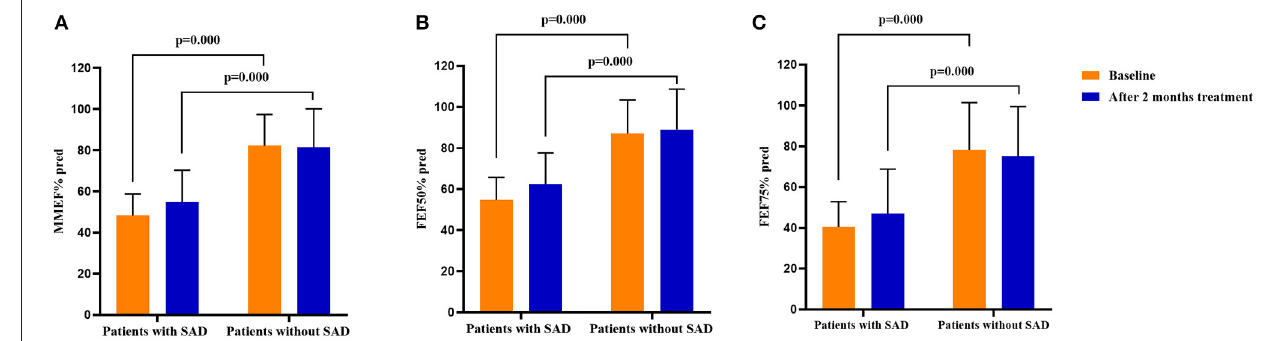
FIGURE 3 | Comparison of the spirometry parameters on small airway function in patients with SAD and patients without SAD at baseline and after 2 months of treatment. (A) The MMEF% pred in patients with SAD and patients without SAD at baseline and after 2 months of treatment; (B) The FEF50% pred in patients with SAD and patients without SAD at baseline and after 2 months of treatment; (C) The FEF75% pred in patients with SAD and patients without SAD at baseline and after 2 months of treatment. SAD, small airway dysfunction. Bars indicate the mean ± SD. MMEF, maximal mid-expiratory flow; FEF50%, forced expiratory flow at 50% of